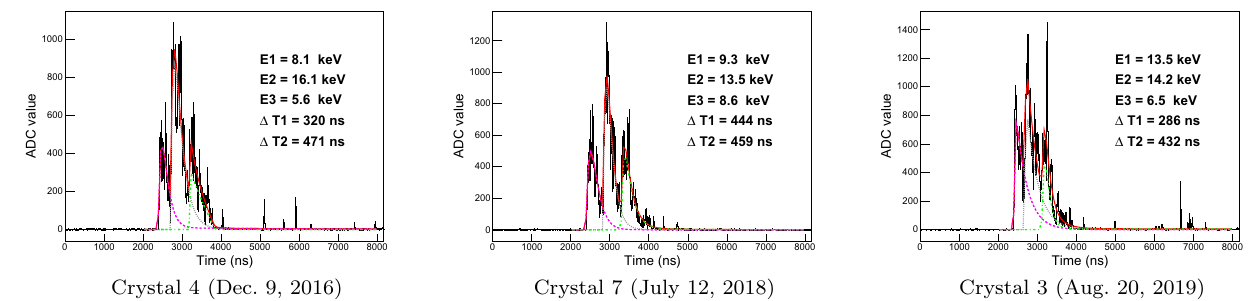
Fig. 6 Examples of the fit results for the three-pulse events from different crystals on different dates. The energies of each pulse (E1, E2, and E3) and the time differences ( (cid:6) T1 and (cid:6) T2) are listed.